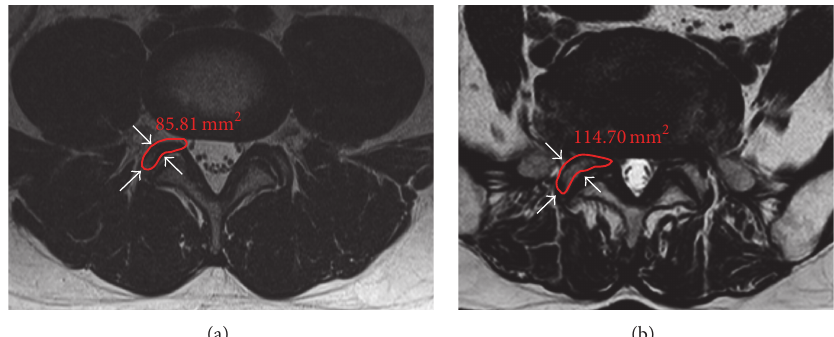
Figure 1: Measurement of the superior articular process area on MRI at the most stenotic level. (a) Control group. (b) Lumbar foraminal stenosis group.